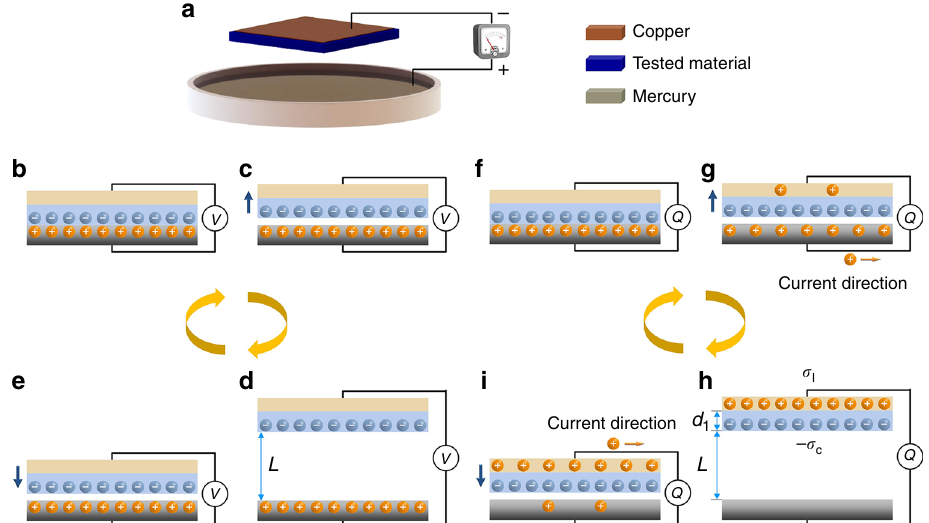
Fig. 1 Principle for measuring the triboelectric charge density. a Simpli fi ed model of the measurement method. The tested material contacts the liquid metal of mercury, and then separates periodically. The positive electrode of the electric meter is connected to the mercury, and the negative is connected to the copper electrode. b – e The Theoretical model under open-circuit condition. b The contact electri fi cation causes charge transfer between materials, the charges coincide at the same plane. The system has no net charge, there is no potential difference. c Voltage is generated between the two electrodes. Suppose the polymer has a strong capacity to absorb electrons, when the materials are separated, the polymer has negative charges, mercury has positive charges. Therefore, the potential difference is created between the two parts. d The potential reaches the maximum when the gap reaches certain distance L . The copper electrode is only in fl uenced by the electric fi elds of the charges on the surface of the polymer. e When the polymer approaches the mercury, voltage drops due to the combined in fl uence of the two electric fi elds. Finally, they are fully contacted, there is no voltage between the two electrodes (back to b ). f – i The theoretical model under a short-circuit condition. f The two materials fully contact each other, there is no potential difference. g When the materials are separated, the negative charges on the surface of the polymer induce positive charges in copper, as copper and mercury are electronically connected, the positive charges in mercury fl ow into the copper side. h Approximately all charges fl ow into copper side to equalize the potential difference when the gap reaches certain distance L . i When the sample approaches the mercury, the negative charges on the surface of the polymer induces positive charges in mercury, the positive charges fl ow from copper to mercury until the charges are neutralized fi nally at the same plane when they are fully contacted (back to f